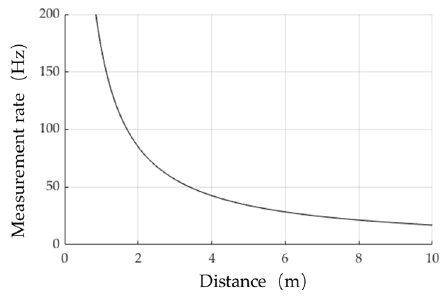
Figure 10. Diagram of the measurement rate and distance.